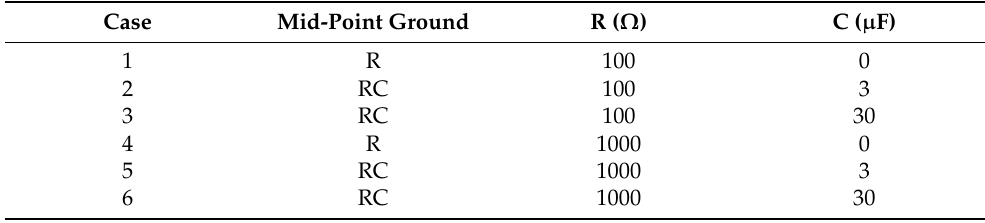
Table 4. Simulation cases according to the mid-point ground with resistors and